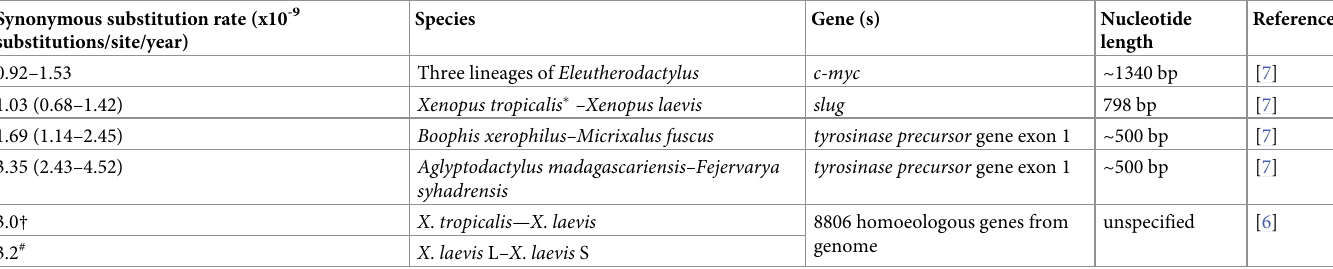
Table 1. Summary of synonymous substitution rates estimated in Anuran frogs in previous studies. Synonymous substitution rate (x10